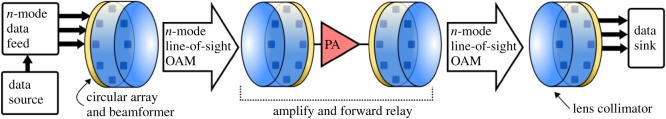
Block diagram of an OAM radio AF relay chain with a data source, relay, antenna array, beamformer, collimating lens and data sink.